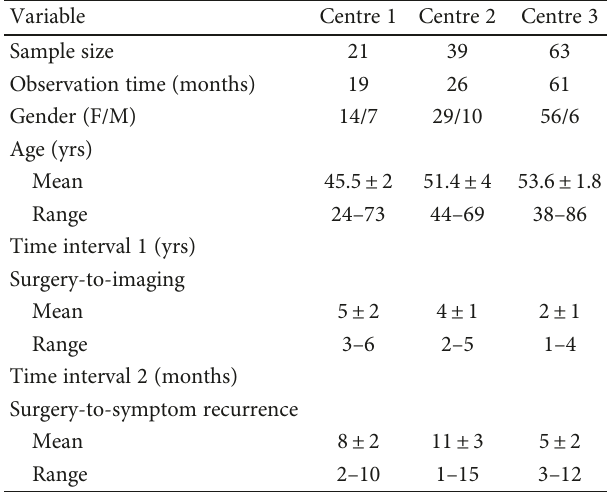
Table 1: Clinical characteristics of the study groups by diagnostic